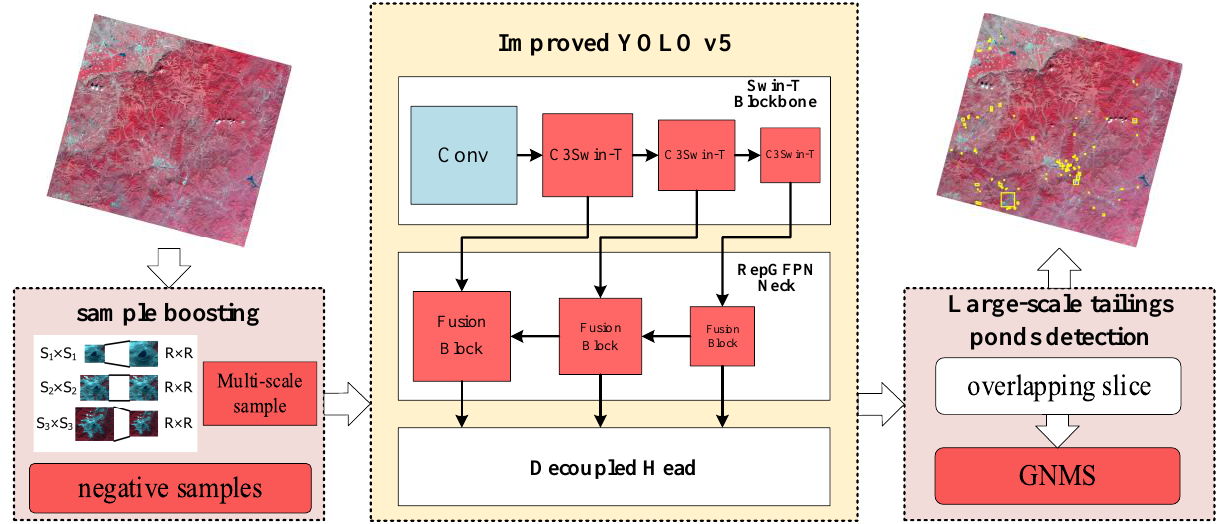
Figure 3. The proposed improved YOLOv5 tailings ponds detection framework.